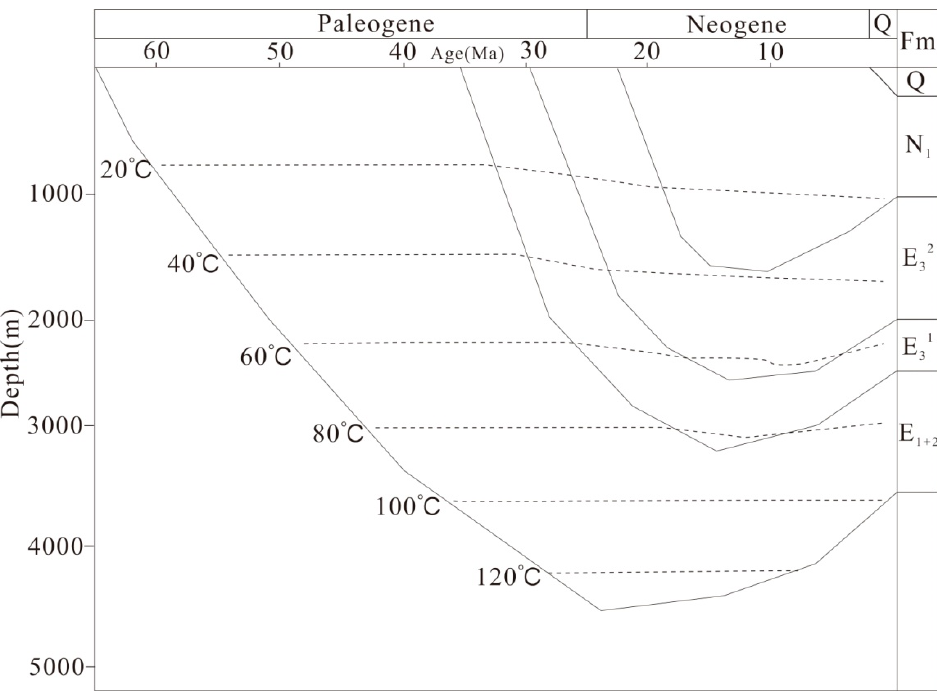
Figure 3. Burial and thermal historiesof thePaleogeneLulehe Formation (E 1+2 ).Figure after Li [34].